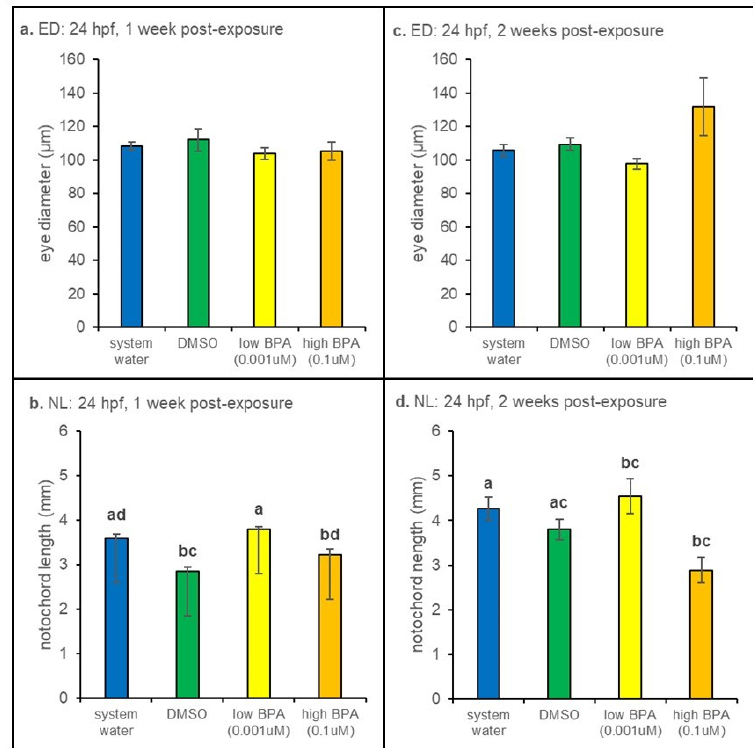
Figure 2 . Twenty-four hours postfertilization anatomical measurements. ( a ) Larvae exposed at 24 hpf did not display any differences in eye diameter after 1 week of recovery. ( b ) However, larvae in the low BPA treatment group were signifi- cantly larger than vehicle controls and larvae exposed to high BPA ( p < 0.001) at 1 week post-exposure. ( c ) After 2 weeks, larvae exposed at 24 hpf still displayed no differences in eye diameter, despite the larger values in the high BPA treatment group. ( d ) Larvae exposed to high BPA had the smallest mean length at 2 weeks post-exposure. Significant differences were noted across treatments ( p = 0.006), however these values were not different from the vehicle control. At each recov- ery point n = 5 for all treatment groups. Differences in notochord length and eye diameter across treatment were assessed using a one-way ANOVA followed by a Tukey post hoc test at each exposure age. Eye diameter measurements were normalized to notochord lengths prior to statistical analysis. All values are reported as mean ± SE. Different letters denote